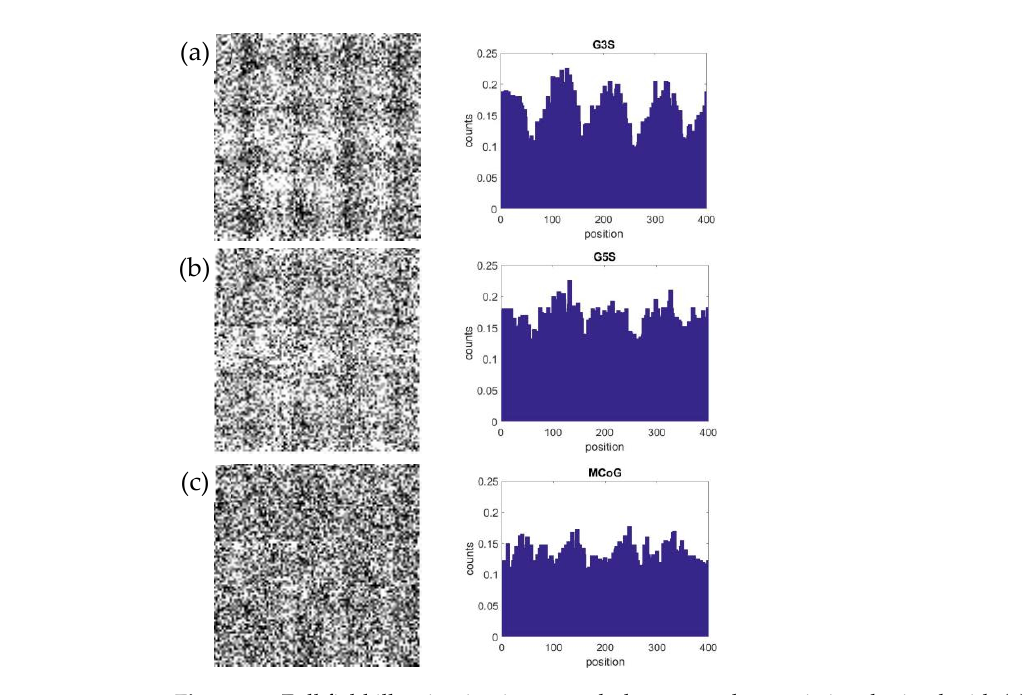
Figure 11. Full field illumination image and photon number statistics obtained with ( a ) G3S, ( b ) G5S and ( c ) MCoG centroiding respectively.